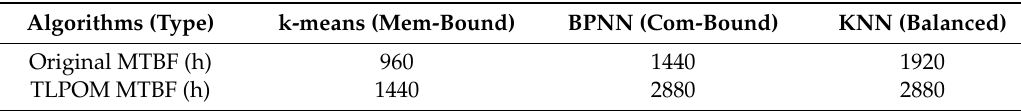
Table 7. The MTBF of different types of applications in the